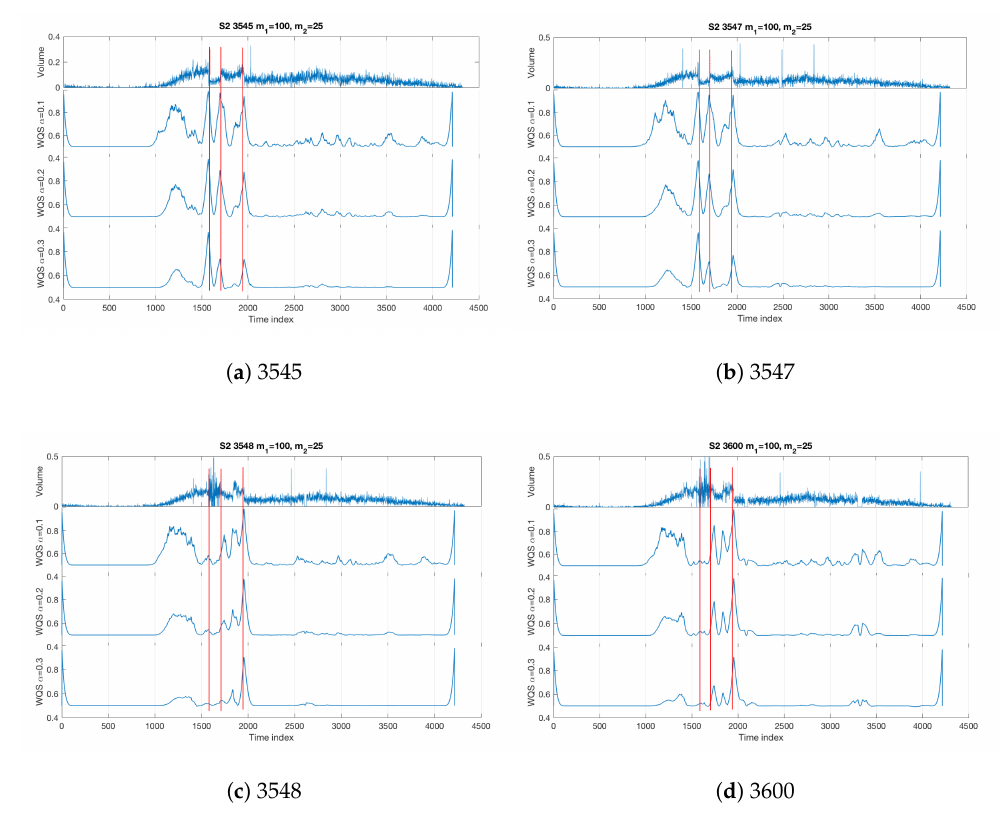
Figure 7. Incident S2 single sensor analysis. The weighting parameters are m 1 = 100, m 2 = 25 over different recurrence plot threshold scales α = 0.1,0.2, 0.3. The vertical red lines refer to the incident start time, incident end time, and queue end time respectively (see Table